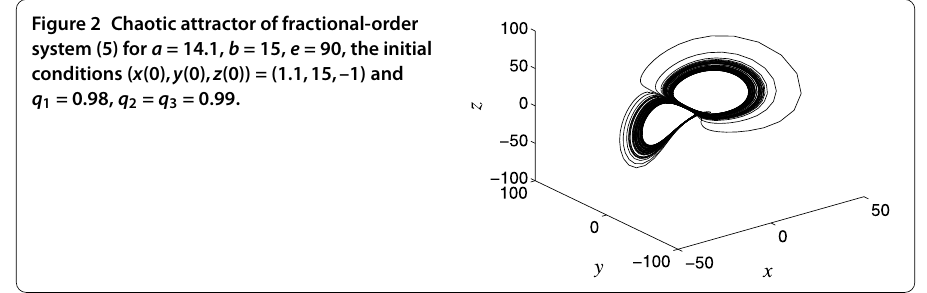
Figure 2 Chaotic attractor of fractional-order system (5) for a = 14.1, b = 15, e = 90, the initial conditions ( x (0), y (0), z (0)) = (1.1,15,–1) and q 1 = 0.98, q 2 = q 3 =